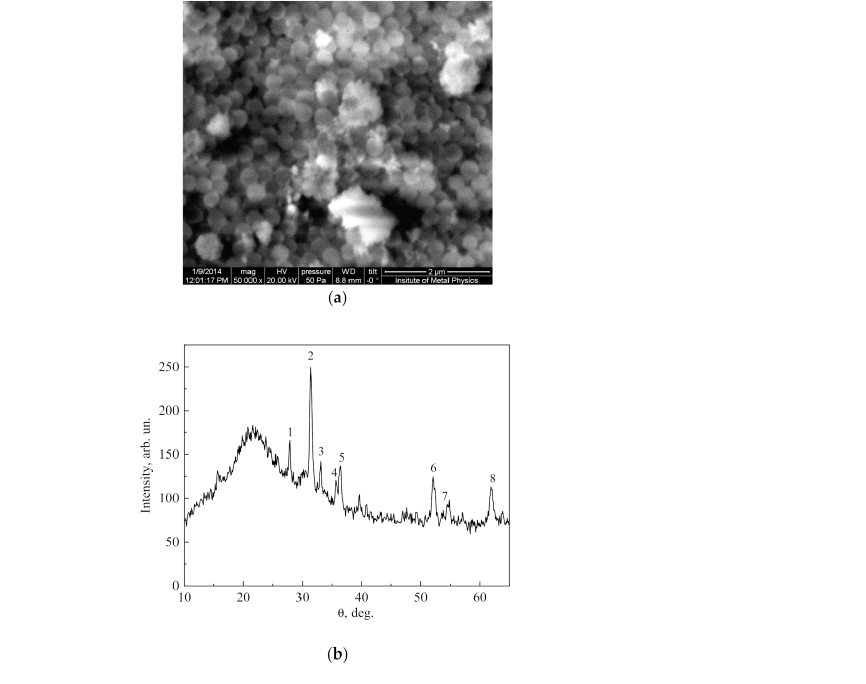
Figure 2. ( a ) Structure of the nanocomposite with the Yb 2 Ti 2 O 7 titanate particles, obtained by using a Quanta-200 scanning electron microscope at an accelerating voltage of 20 kV and a magnification of × 50,000; ( b ) X-ray diffraction pattern of the nanocomposite with the Yb 2 Ti 2 O 7 titanate